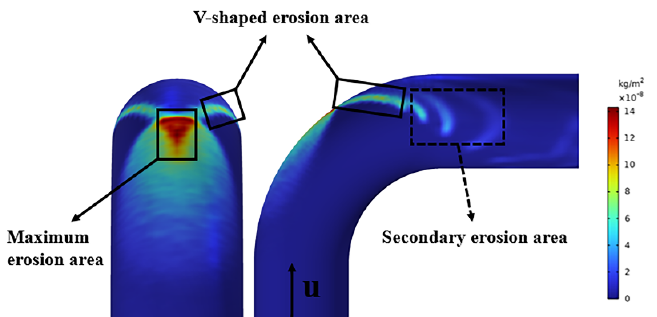
Figure 8. Erosion nephogram with 100 μ m sulfur particle erosion at a flow rate of 15 m/s.